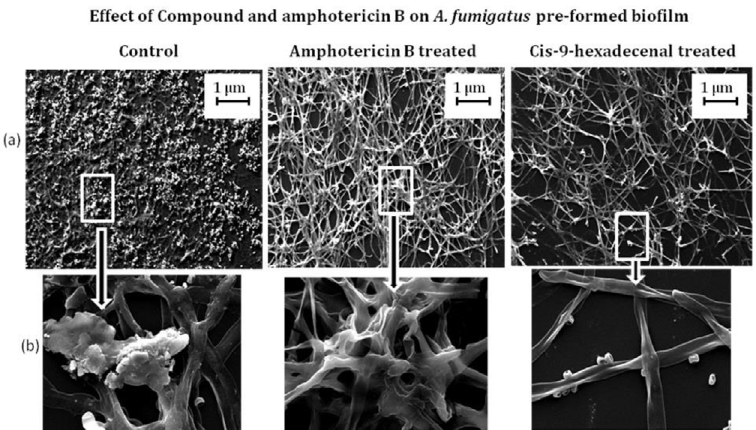
Fig. 4. Scanning electron micrographs illustrating A. fumigatus biofilm formation in treated and wild type A. fumigatus . The developed biofilm was treated with drug Amphotericin B and cis-9-hexadecenl for 24 h and then viewed under scanning electron microscope. The magnification of (a) is 500 X and (b) is 5 K X.